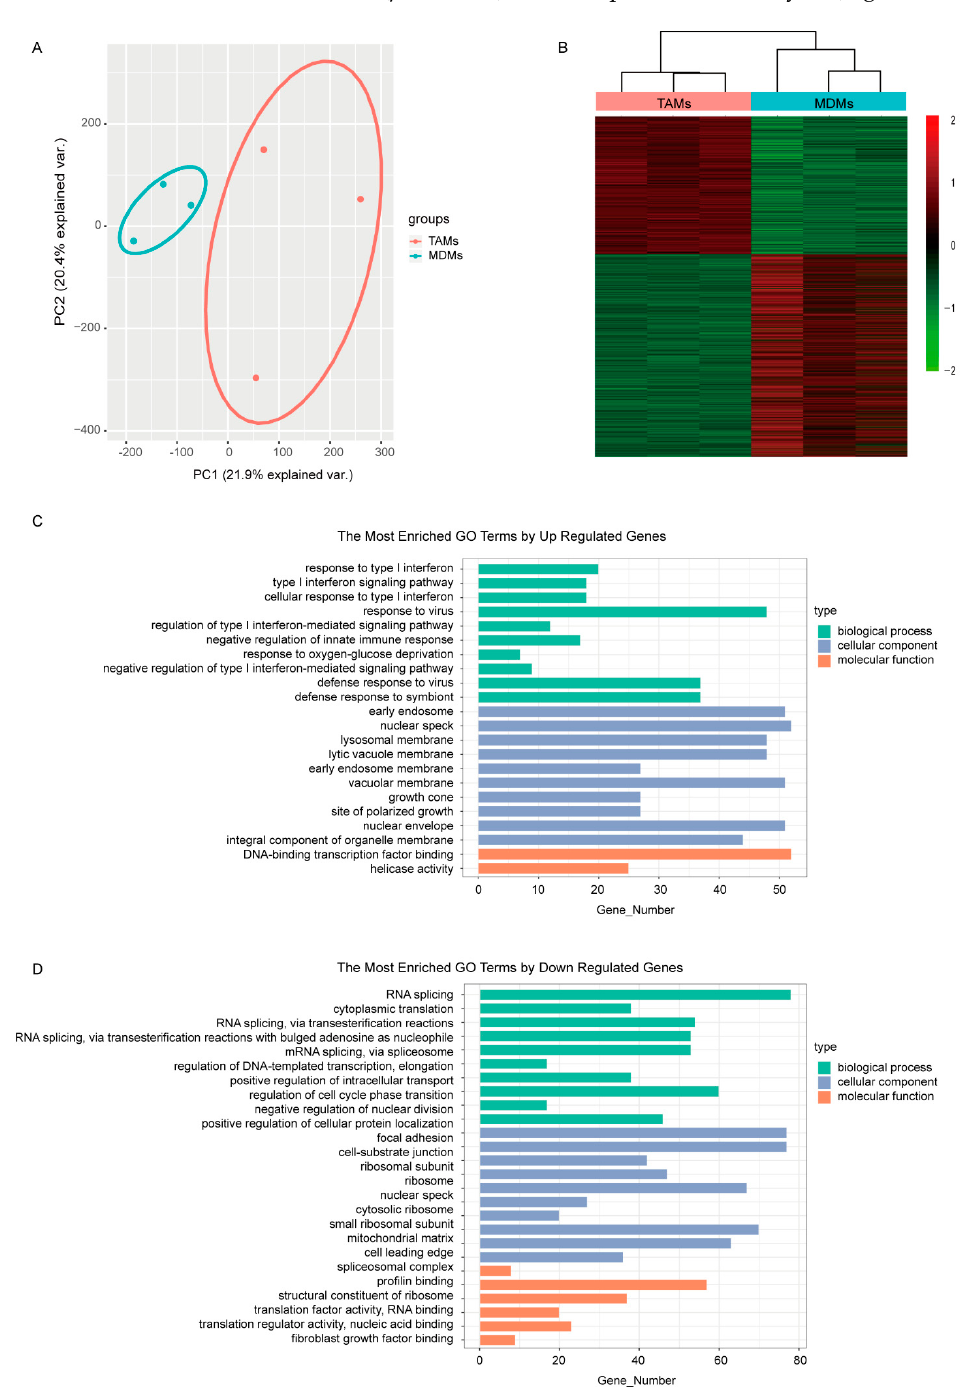
Figure 1. Comparison of the transcriptomes induced by medium from MDMs or TAMs. ( A ) The PCA figure of the MCF7 transcriptomes. ( B ) Heatmap of DEGs in MCF7 transcriptomes induced by either MDMs or TAMs. ( C , D ) GO enrichment analysis of the upregulated and downregulated DEGs separately. The pathways shown here were most significantly enriched ( p < 0.05, q <